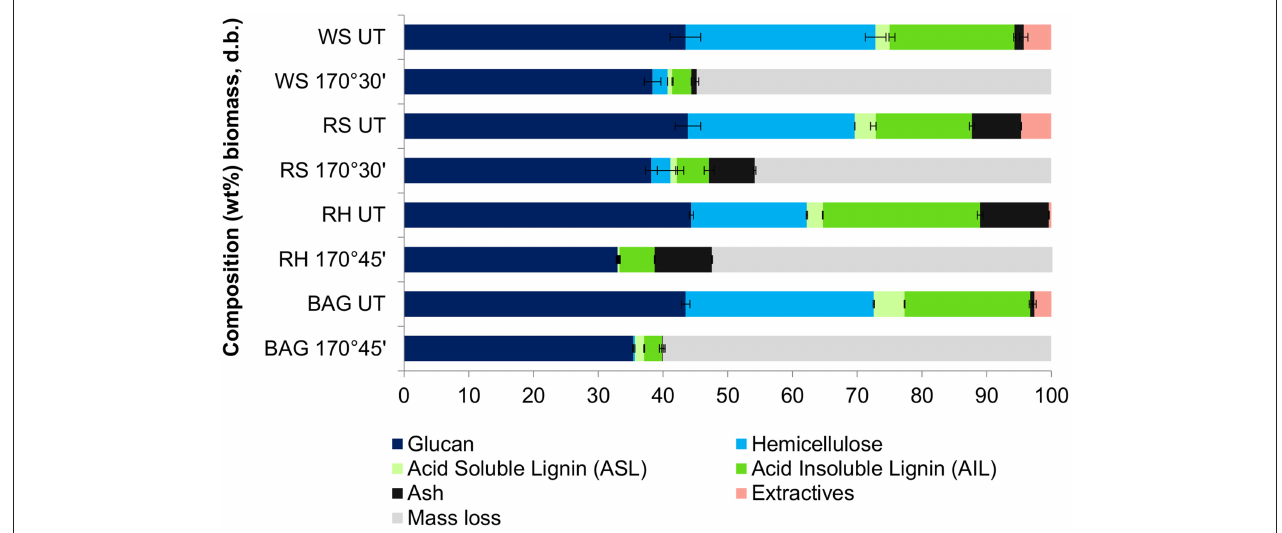
FIGURE 5 | Chemical composition of untreated (UT) and pre-treated cellulose-rich pulps isolated from pretreatment of rice husk, sugarcane bagasse, wheat straw, and rice straw with [TEA] and [HSO 4 ] under optimized conditions.